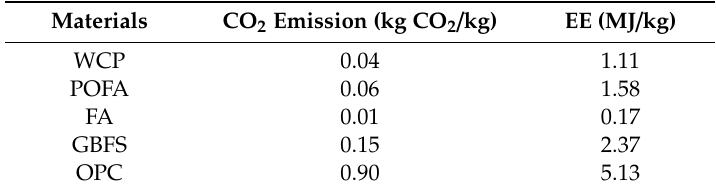
Table 6. EE and CO 2 emission of employed industrial waste material and OPC.